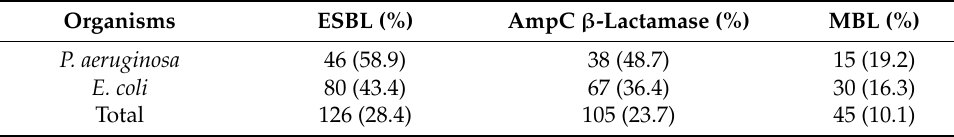
Table 5. Distribution of antibiotic-resistant genes in bacterial